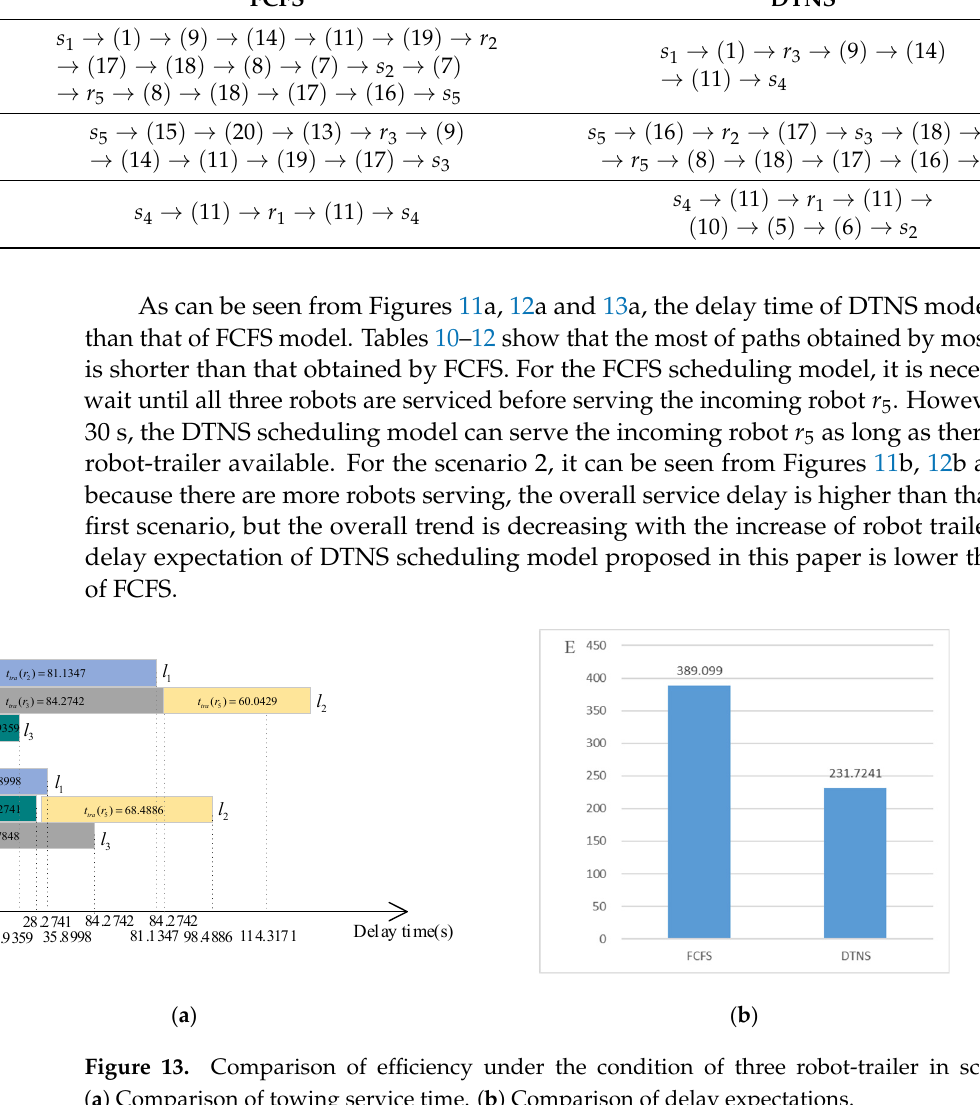
Table 12. Paths obtained by FCFS and DTNS under the condition of three robot-trailer in scenario 2. Robot-Trailer FCFS